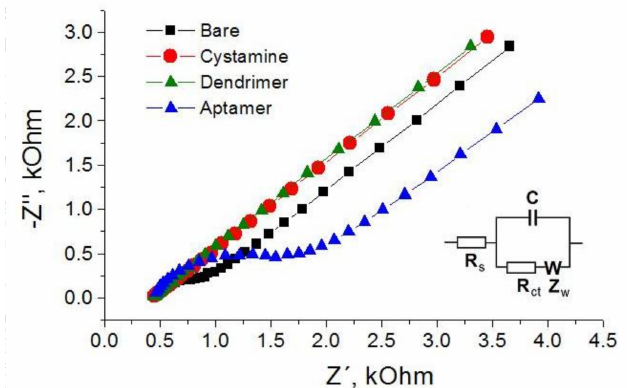
Figure 2. Nyquist plots corresponding to the main steps of aptasensor preparation from bare gold surface to cystamine layer, dendrimer adlayer and finally after immobilization of aptamers (see the legend). Inset represent Randles equivalent circuit that models electrical properties of the layers. R s and R ct are the electrolyte and charge transfer resistances, respectively. Z w is the Warburg impedance resulting from the diffusion of the redox probe and C is the capacitance of the electrode surface/solution interface. Experiments were performed in the working phosphate buffer containing 5 mM (1:1) [Fe(CN) 6 ] 3 − /4 − as a redox